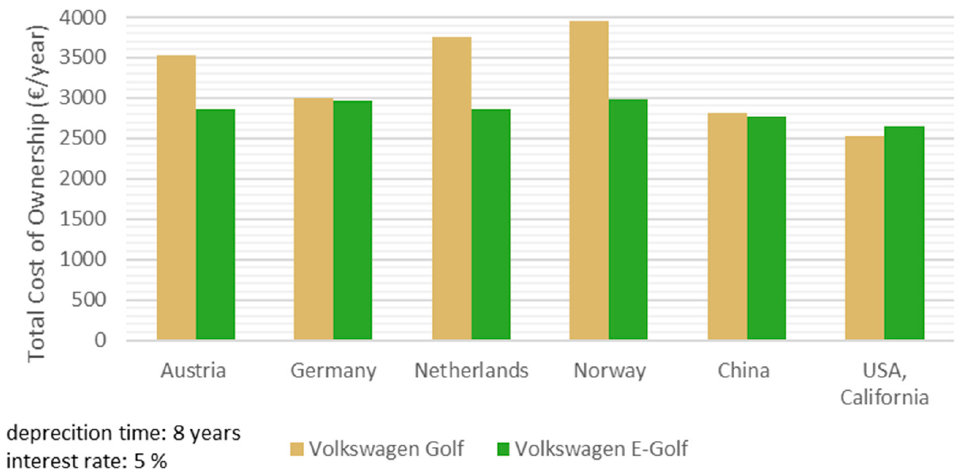
Figure 8. Total cost of ownership (TCO) (Case 1)—VW Golf vs. E-Golf.